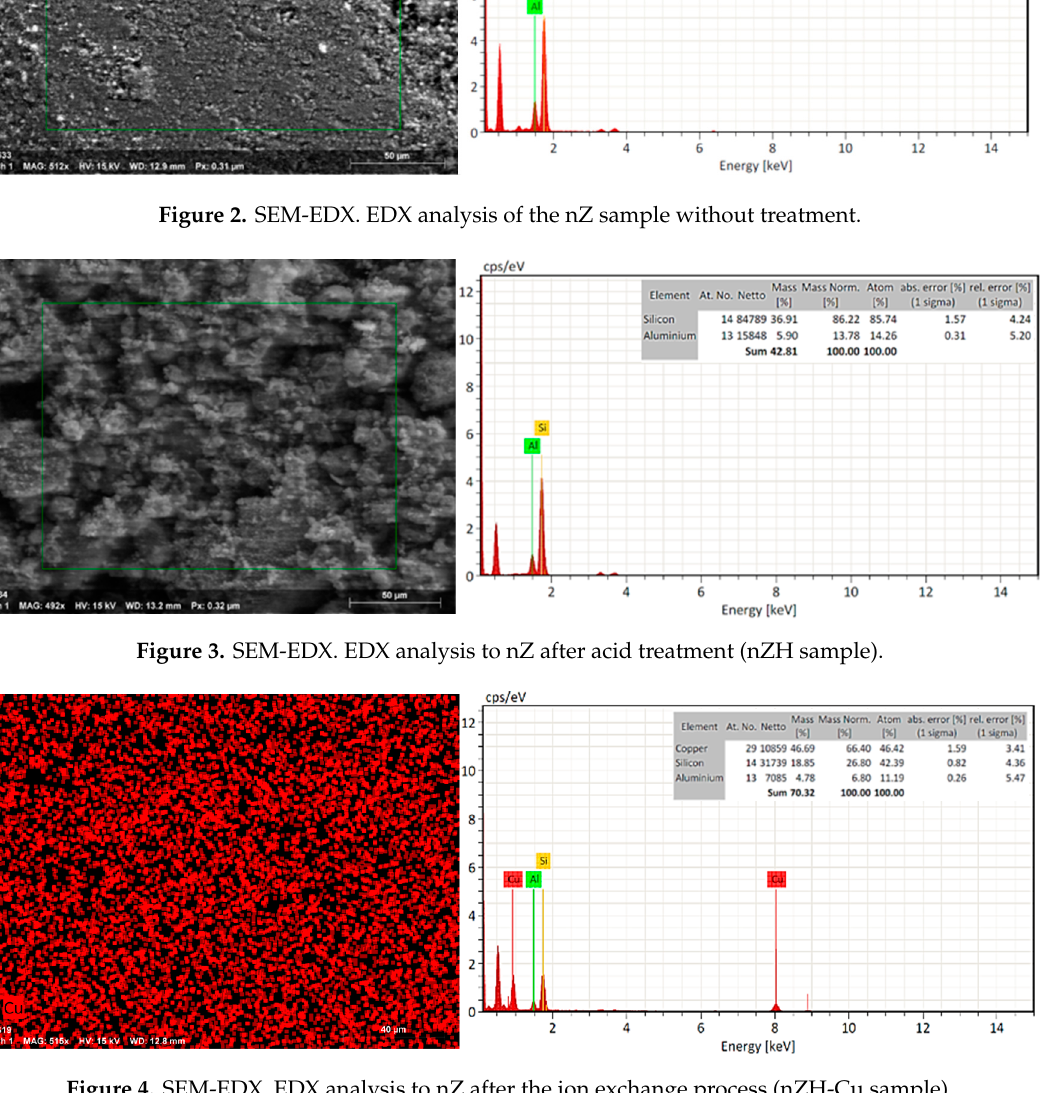
Figure 4. SEM-EDX. EDX analysis to nZ after the ion exchange process (nZH-Cu sample).